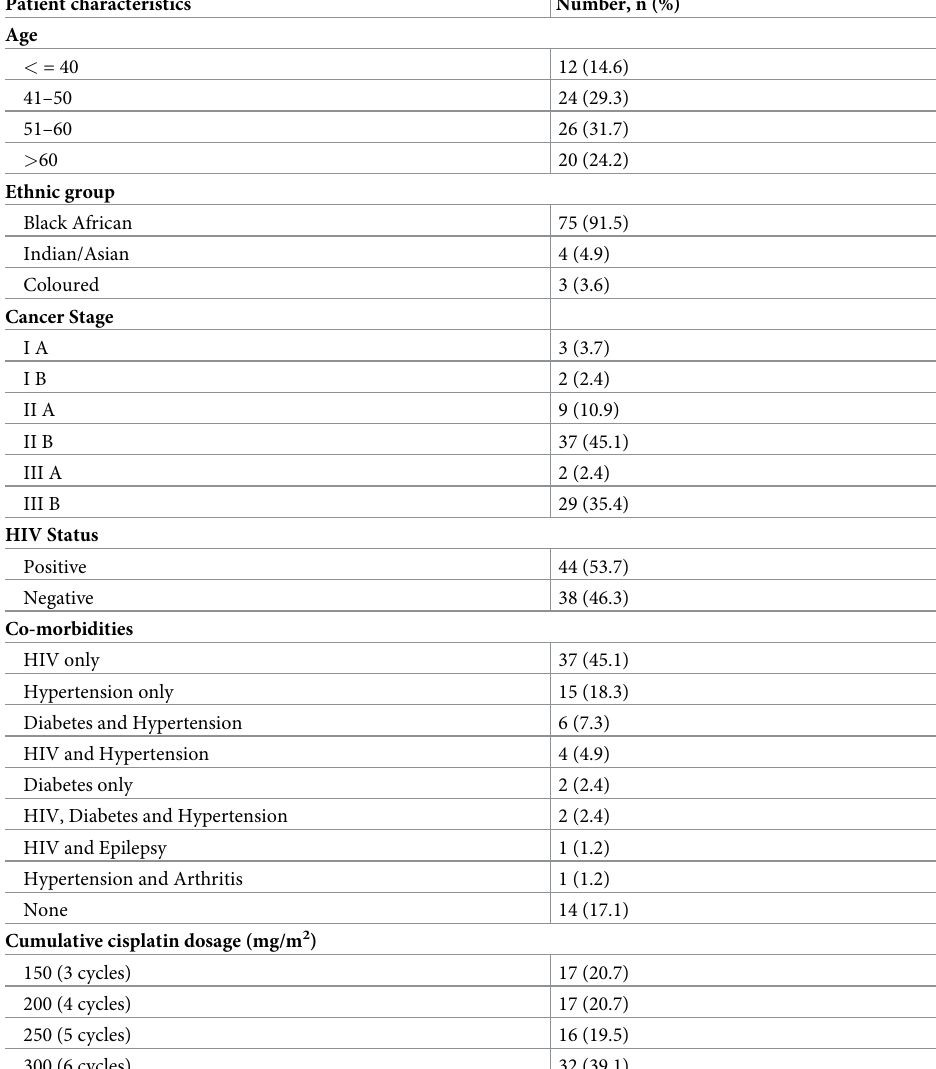
Table 1. Demographic and medical characteristics of the participants, n